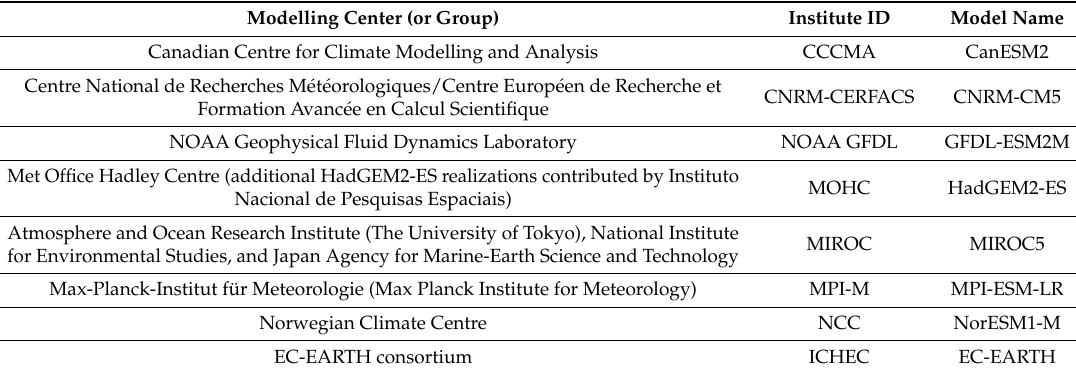
Table 2. List of CMIP5 GCM models considered in the